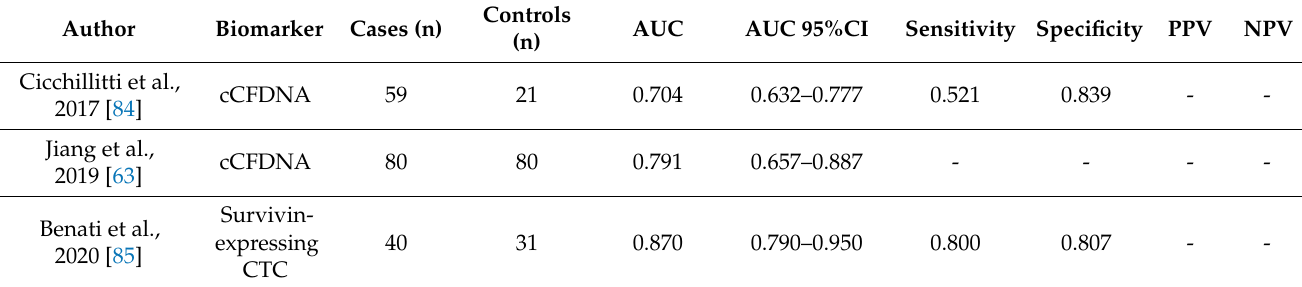
Table 17. Summary table of the performance of circulating tumor not eligible for inclusion in